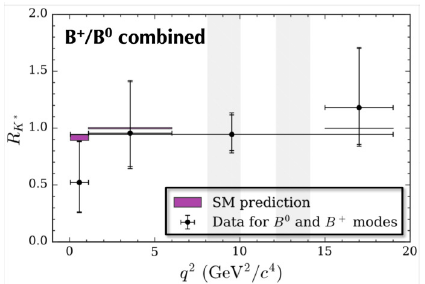
Figure 5. Result for R K ∗ compared to SM predictions in bins of q 2 ∈ [0 . 045 , 1 . 1], [1 . 1 , 6], [15 , 19], and [0 . 045 , 19] GeV 2 / c 4 . The shaded bands indicate the charmonium